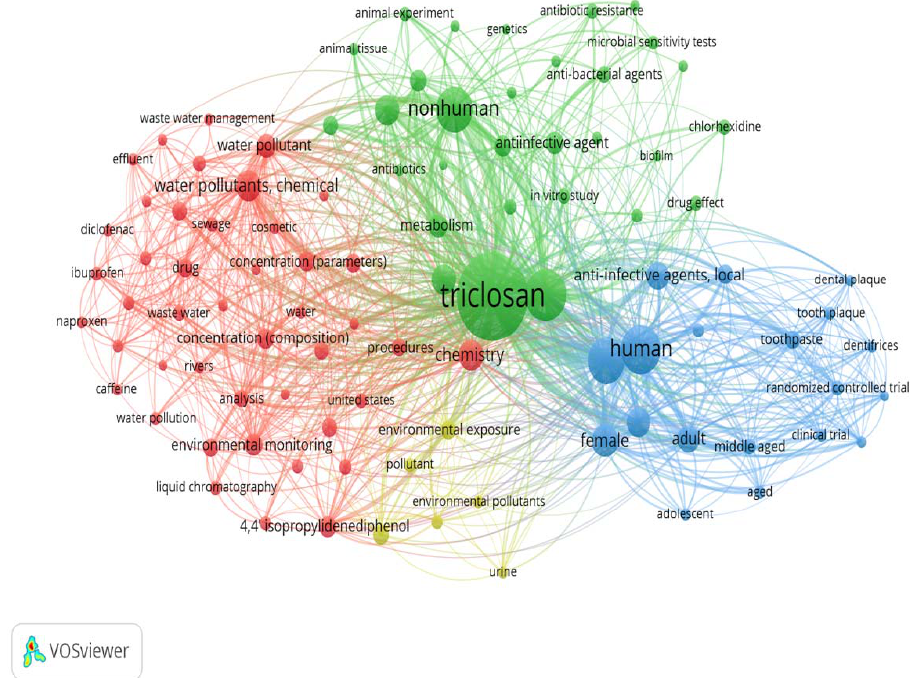
Figure 7. Network analysis by keywords used in TCS-related publications. Colors represent differing concentrations. Red represents “environmental impacts”. Green represents “antibiotic resistance”. Blue represents the use of “TCS in dentifrices”.